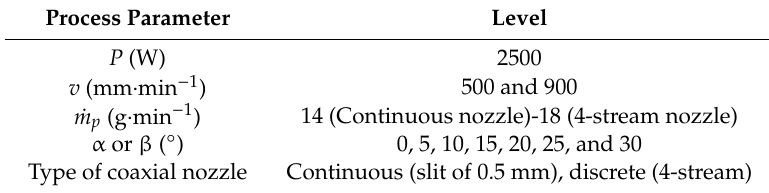
Table 3. Process parameters for the analysis of the effect of tilting and non-perpendicular deposition.